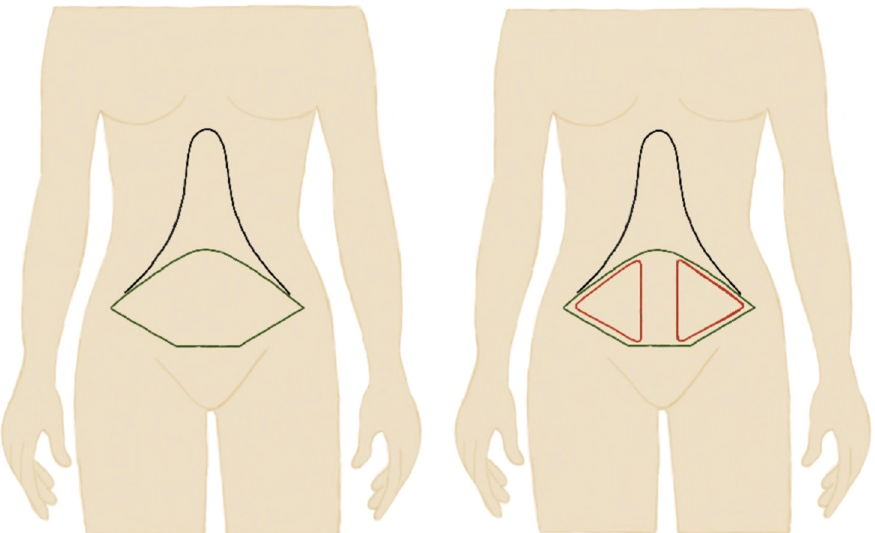
Figure 1. Schematic representation of classic full plane abdominoplasty versus Scarpa preservation abdominoplasty (SPF) where Scarpa fascia was preserved in the red areas.